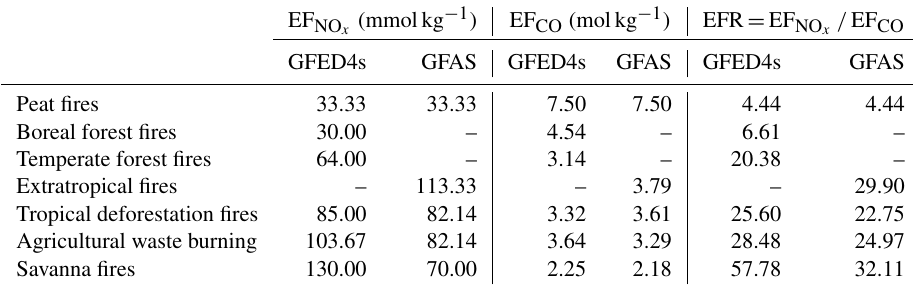
Table 1. Emission factors for NO x (emitted as NO) and CO used by GFED4s (mostly based on Akagi et al., 2011, and a few other sources) and GFAS (mostly based on Andreae and Merlet, 2001, with additional updates) for different types of biomass burning. The final two columns and EF CO (EFR) for the two emission databases. The original units (gkg − 1 ) are converted to on the right show the ratio between EF NO x and EF CO , respectively, to make units of EFR equal to TROPOMI mole density mmolkg − 1 and molkg − 1 for EF NO x